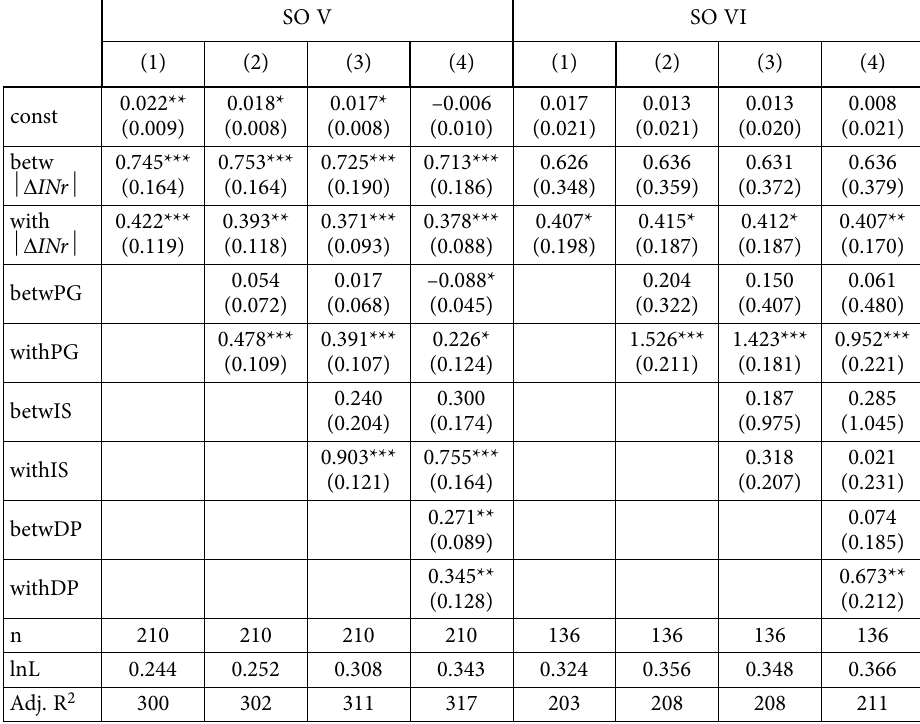
Table 6. Pooled OLS estimates for Vth and VIth SO class (robust HAC standard errors, dependent variable D